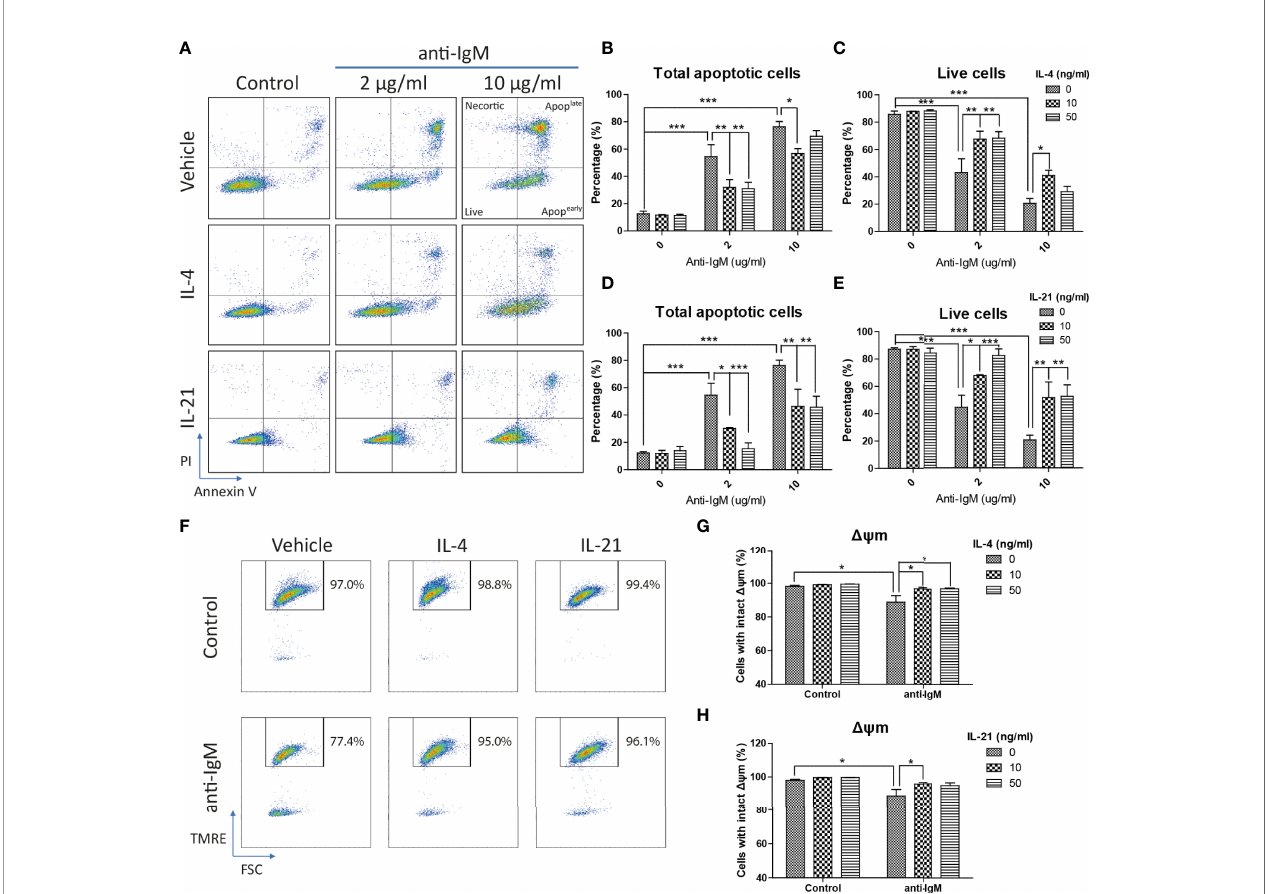
FIGURE 3 | IL-4 and IL-21 rescued anti-IgM induced apoptosis and mitochondrial dysfunction. (A) Representative images showed that IL-4 and IL-21 suppressed anti-IgM induced early (bottom right quadrant, AV+PI-) and late (top right quadrant, AV+PI+) apoptosis, and shifted the cells back to live population (lower left quadrant, AV-PI-). Quanti fi cation showed that (B, C) IL-4 signi fi cantly reduced apoptotic population in both concentrations while (D, E) IL-21 signi fi cantly reduced apoptotic population in a dose dependent manner. (F) Representative images showed that IL-4 and IL-21 reversed anti-IgM (2 µg/ml) triggered loss of Dy m in Ramos. (G, H) Quanti fi cation con fi rmed the observation from the representative images. *p < 0.05, **p < 0.01, ***p < 0.001 as compared to indicated groups by two-way ANOVA, N =